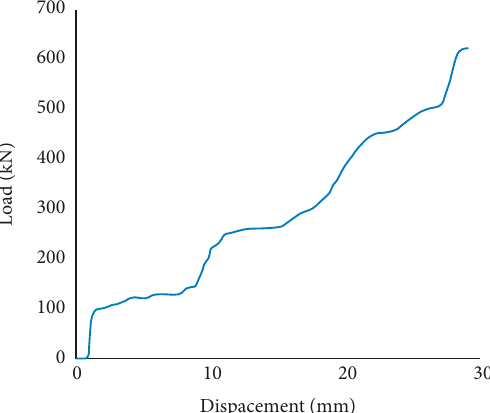
Figure 21: Load-deflection behavior of GG35 specimens strengthened with wrapping.